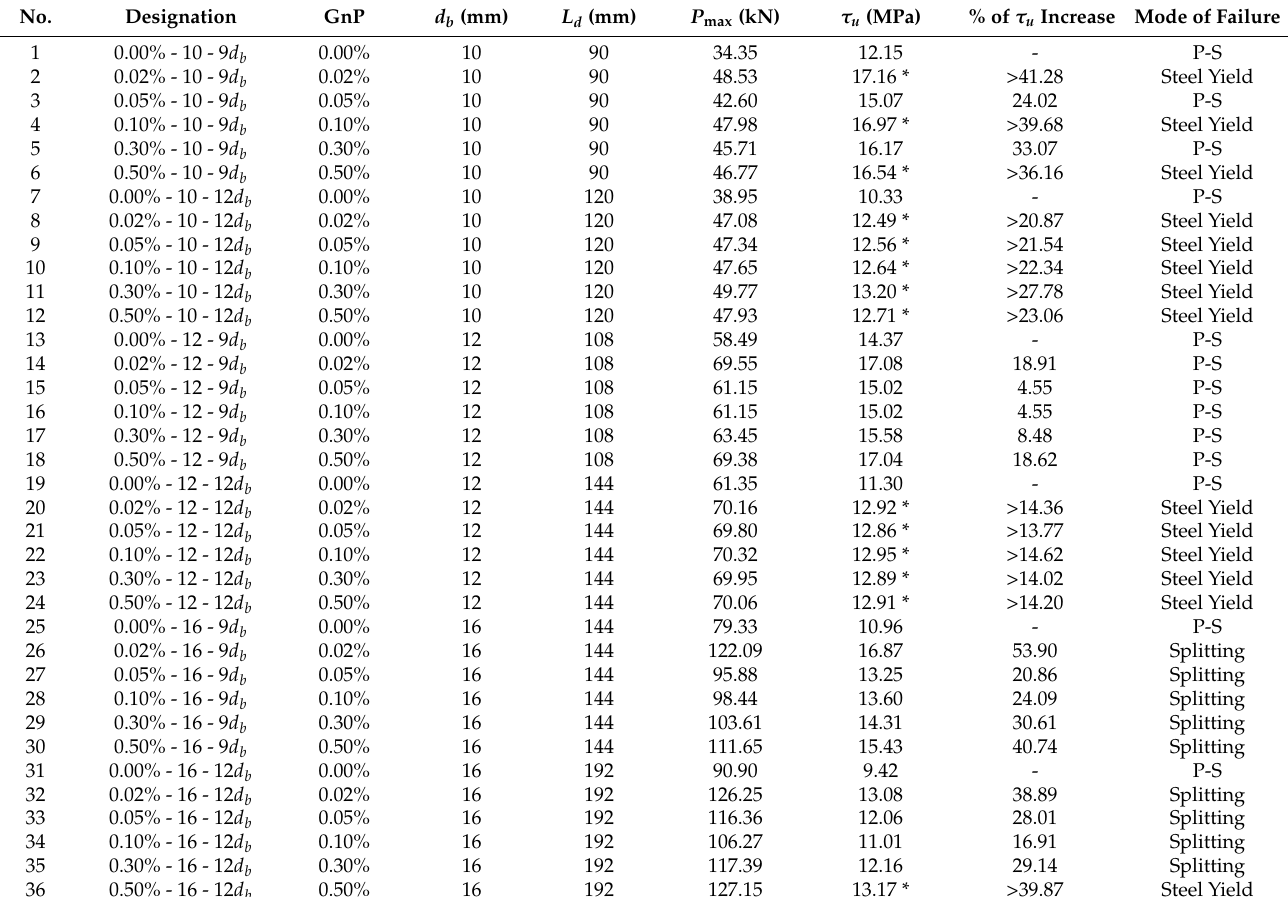
Table 7. Test Results for Simple Bar